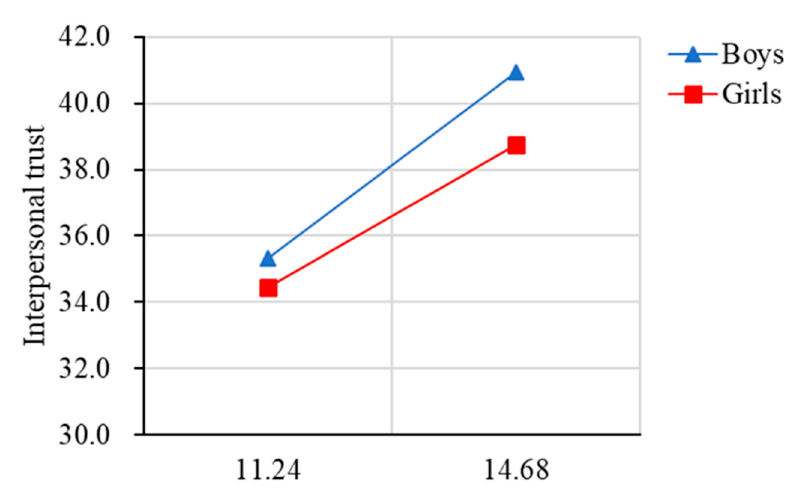
Figure 6. Gender moderated the relationship between age and interpersonal trust. Note: Higher score of interpersonal trust represents interpersonal mistrust.